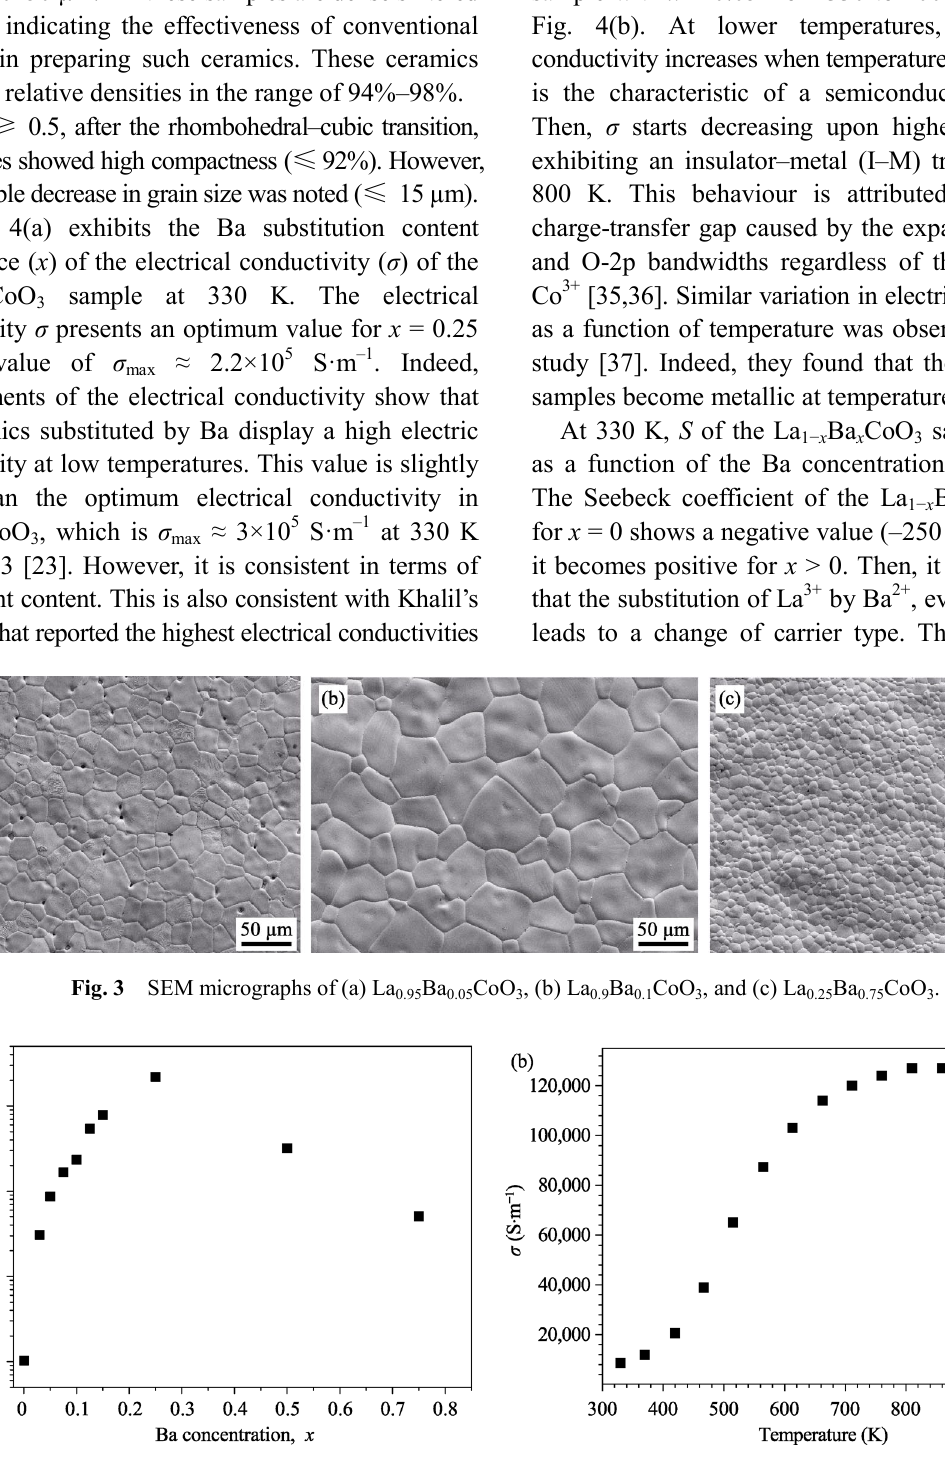
Fig. 4 σ for La 1 − x Ba x CoO 3 (a) with 0 ≤ x ≤ 0.75 at 330 K and (b) with x = 0.05 at different